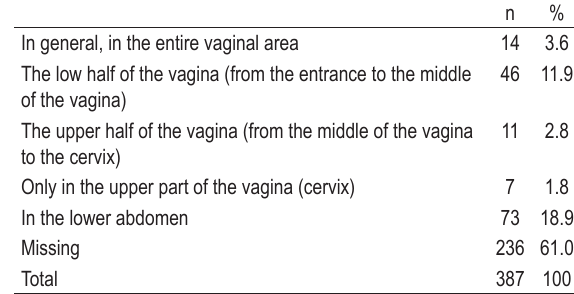
TABLE 11. Location of the pain sensation after sexual